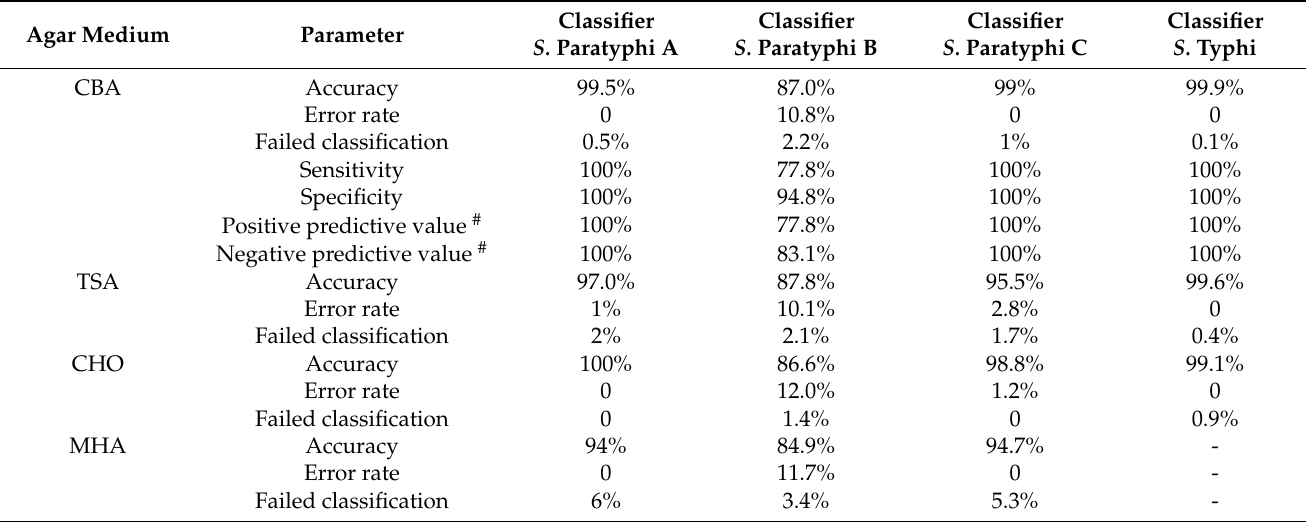
Table 3. Performance of the automated classifiers with different testing